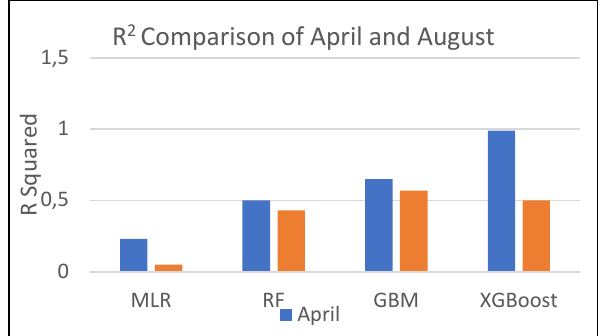
Figure 10. R 2 Comparison of April and